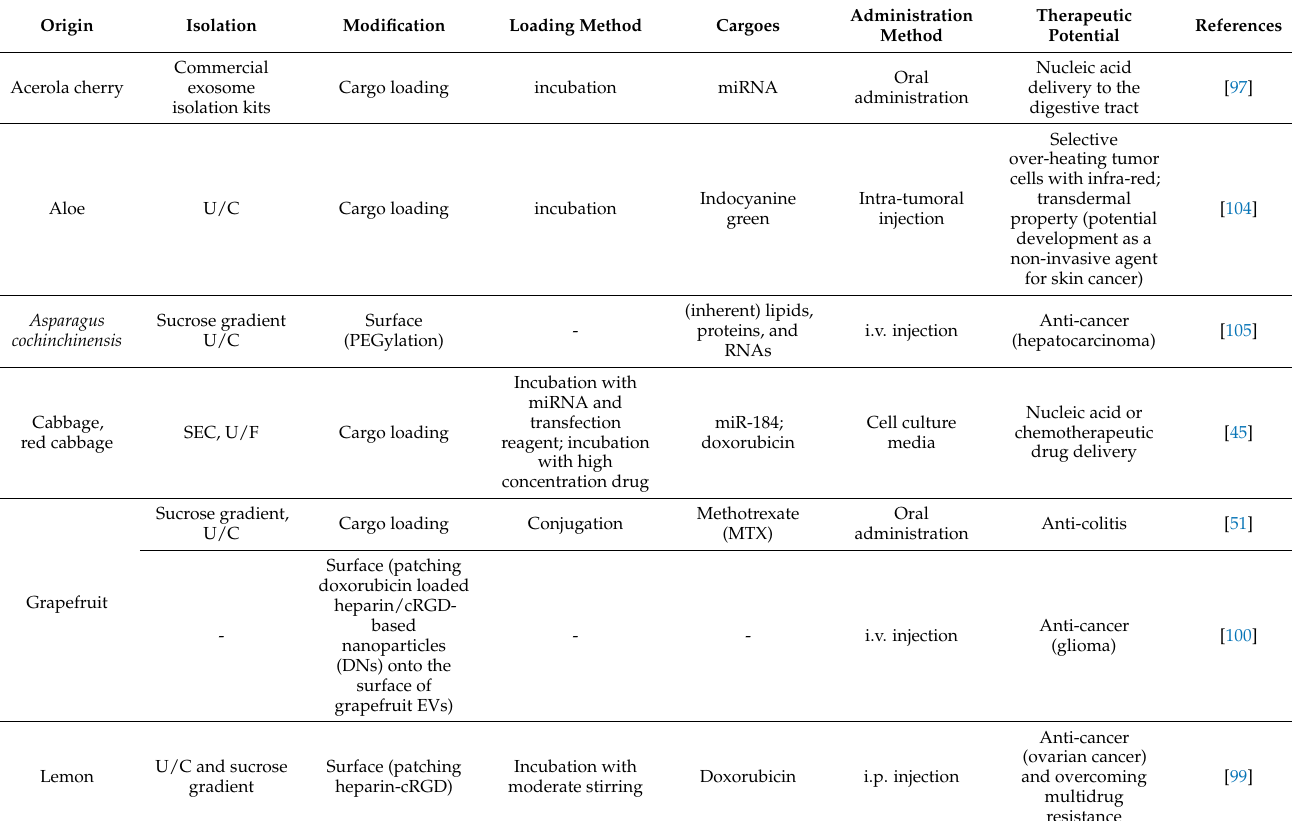
Table 3. PDNVs as